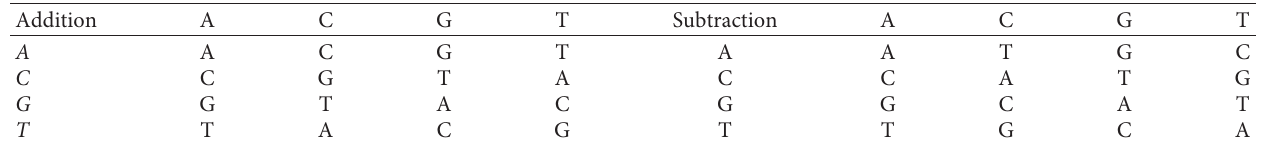
Table 2: DNA encode rule.